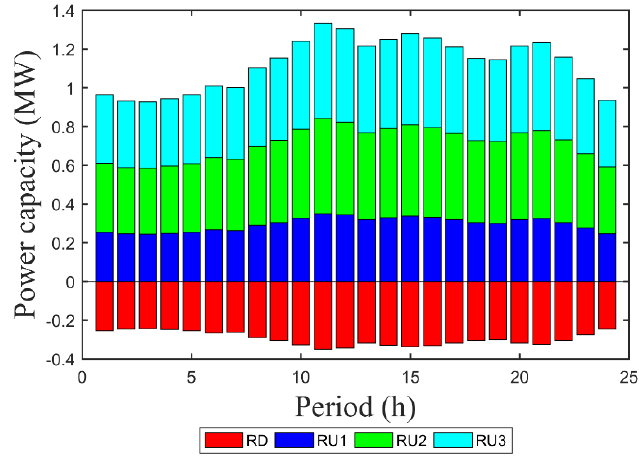
Figure 6. Reserve capacity rescheduling at hour-ahead stage.